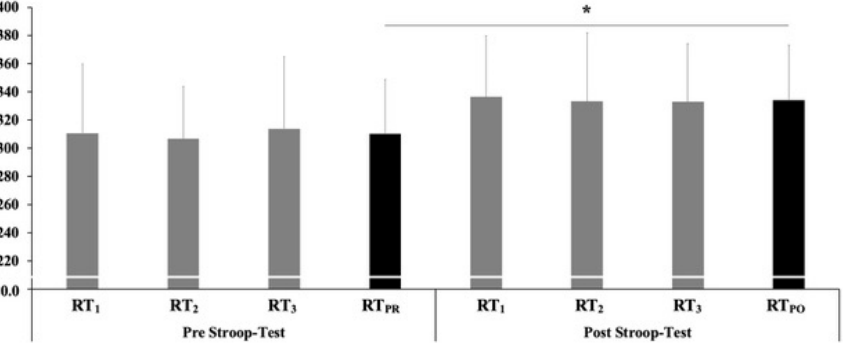
Figure 4. Pre-/post-Stroop test reaction time (single tests RT 1,2,3, in grey color). Average (in